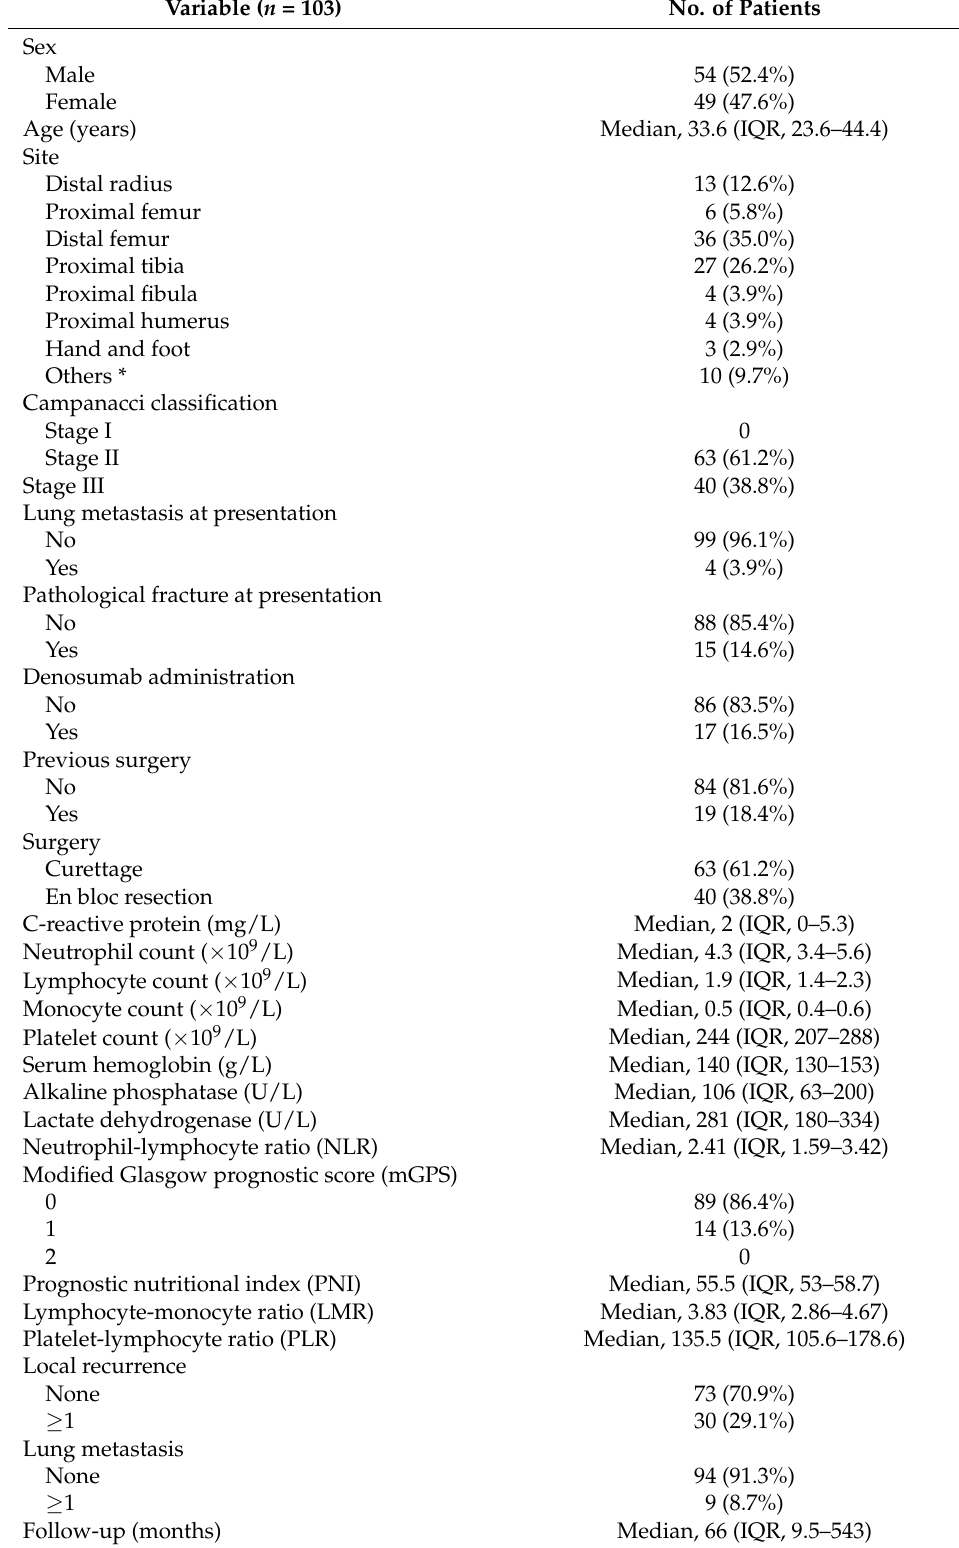
Table 1. Patient characteristics included in this